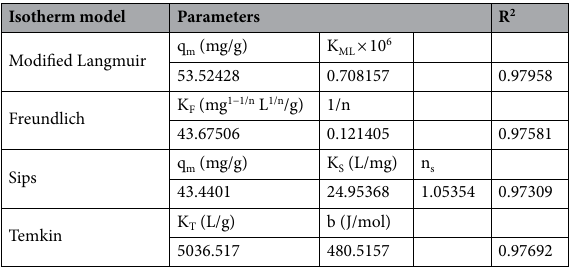
Table 3. Adsorption isotherm model parameters for Cr(VI) removal by